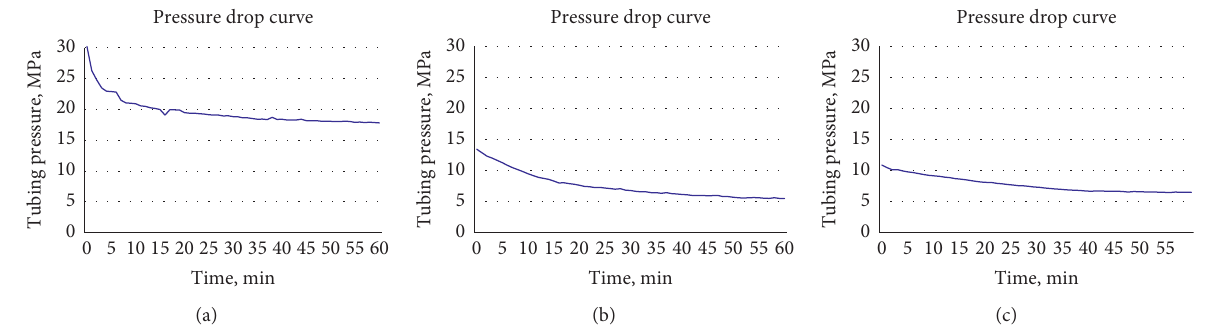
Figure 8: The typical pressure drop curves. (a) The decline rate is high. (b) The decline rate is moderate. (c) The decline rate is low.